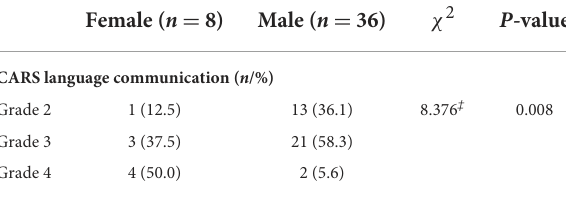
TABLE 2 Sex differences of CARS language communication